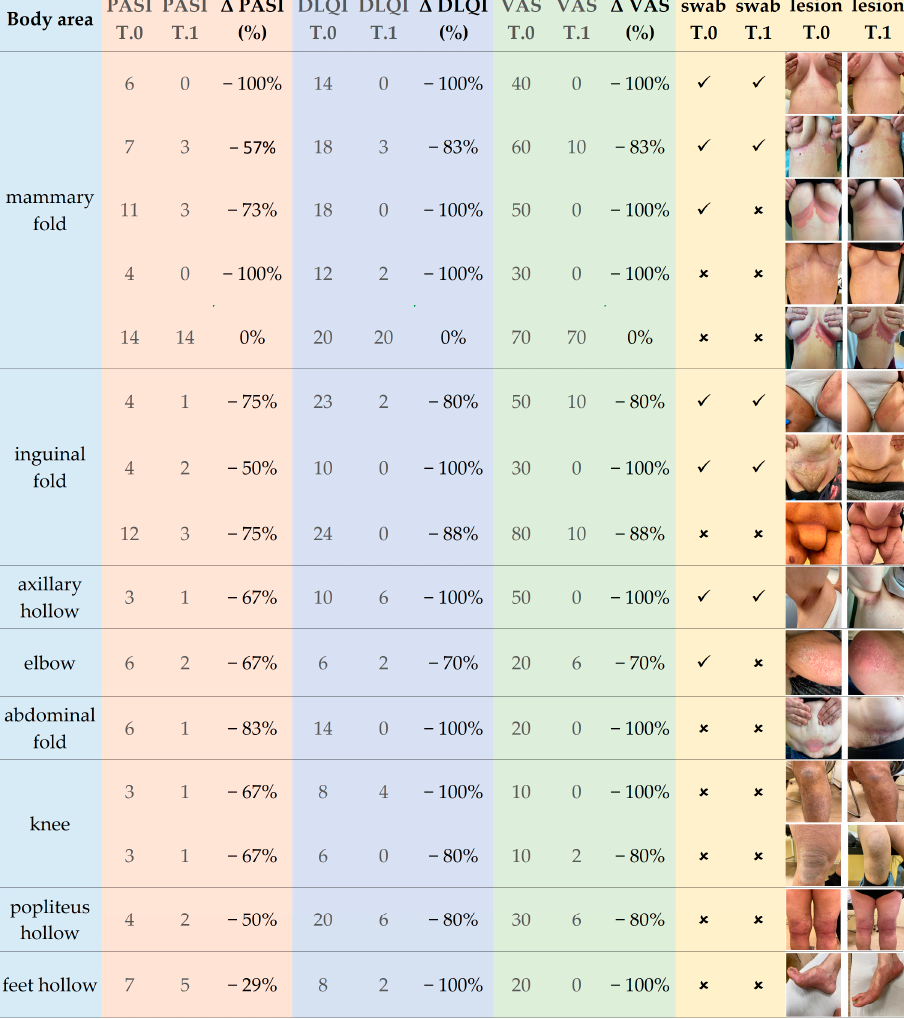
Figure 1. Clinical outcomes. In the first light-blue column, the body area sampled is indicated. The pink, blue, and green columns report the score and the percentage variation ( Δ ) of PASI, DLQI, and itch VAS indexes, respectively. In the yellow columns, the tick and cross symbols indicate whether the swab was collected or not collected.